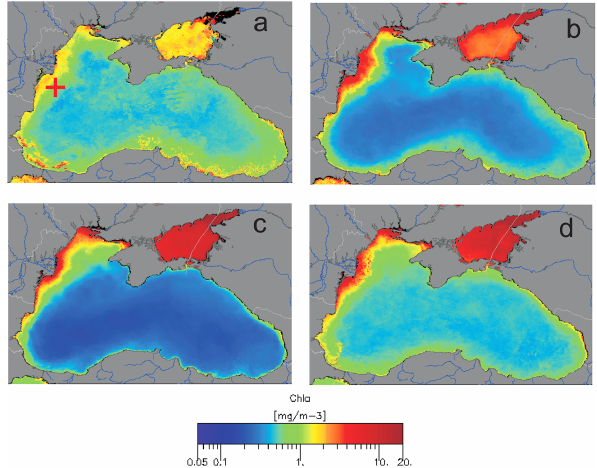
Figure 1. Monthly climatology maps of Chl a for the Black Sea ( a January; b April; c July; d October) obtained from the application of a regional bio-optical algorithm (see Sect. 3.3 for details) applied to MODIS-A data. The red symbol “ + ” in panel (a) indicates the location of